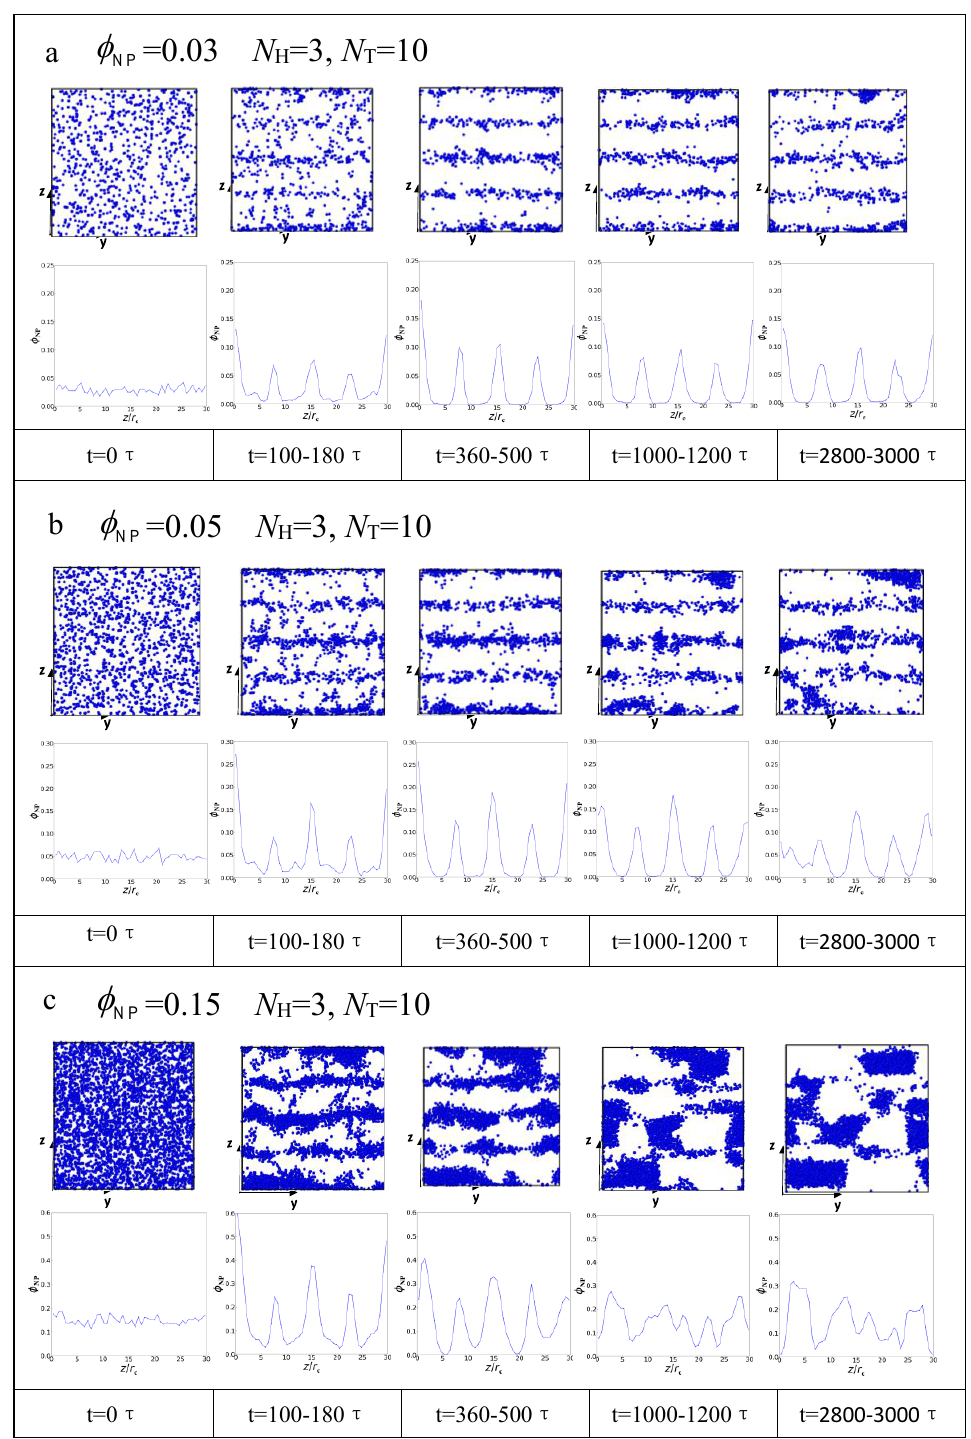
Figure 6. The dynamic processes for position distributions of nanoparticles in lamellar structures with ( a ) φ NP = 0.03, ( b ) φ NP = 0.05 and ( c ) φ NP = 0.15 .The upper line shows the schematic diagram of nanoparticles at each time stage, and the lower line displays the corresponding density profiles of